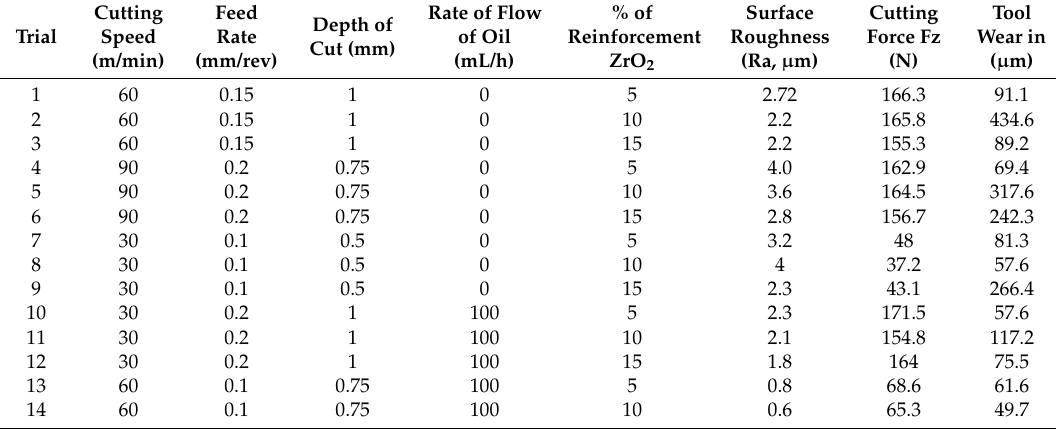
Table 4. Combinations of machining parameters and observed response